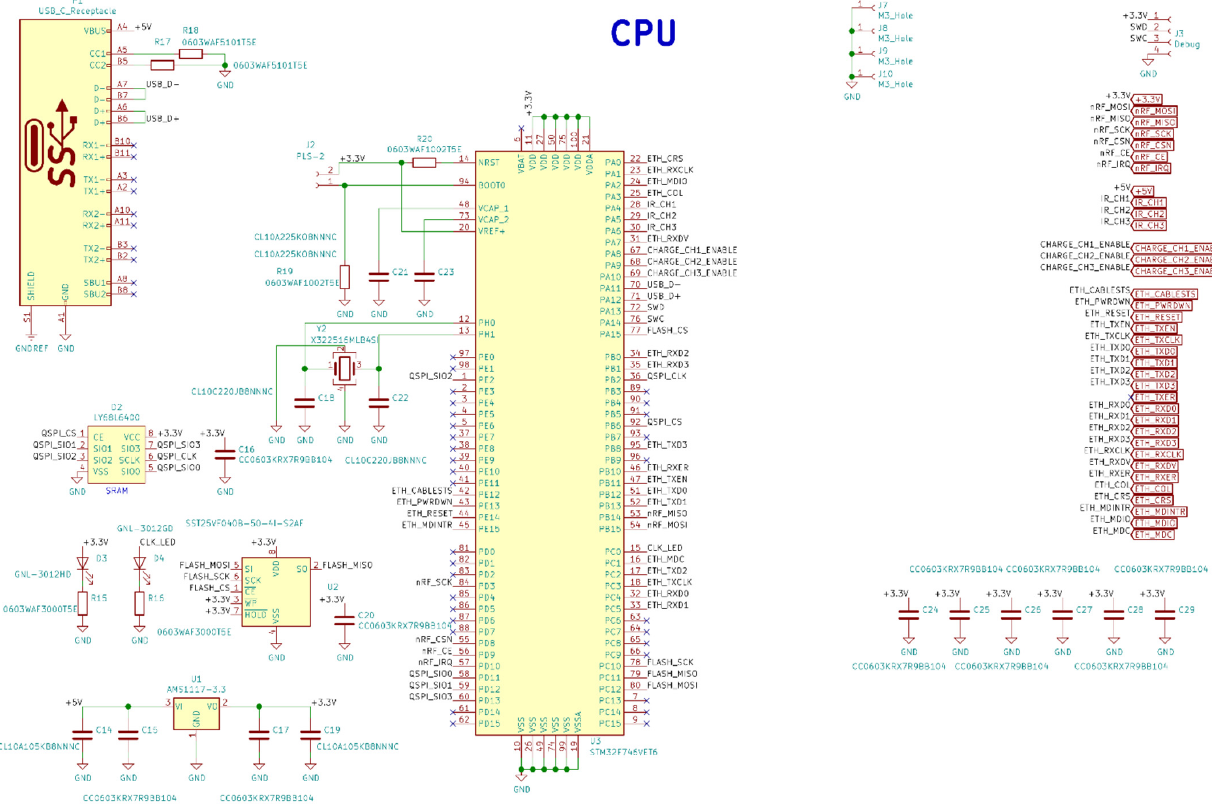
Figure A6. Base station PCBs: ( a ) Layer B_Cu, ( b ) Layer F_Cu, ( c ) Layer In1_Cu, ( d ) Layer In2_Cu.